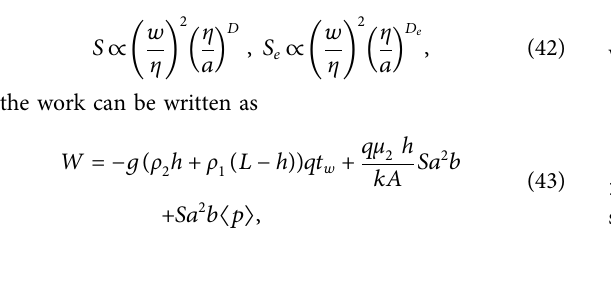
Frontiers in Physics |